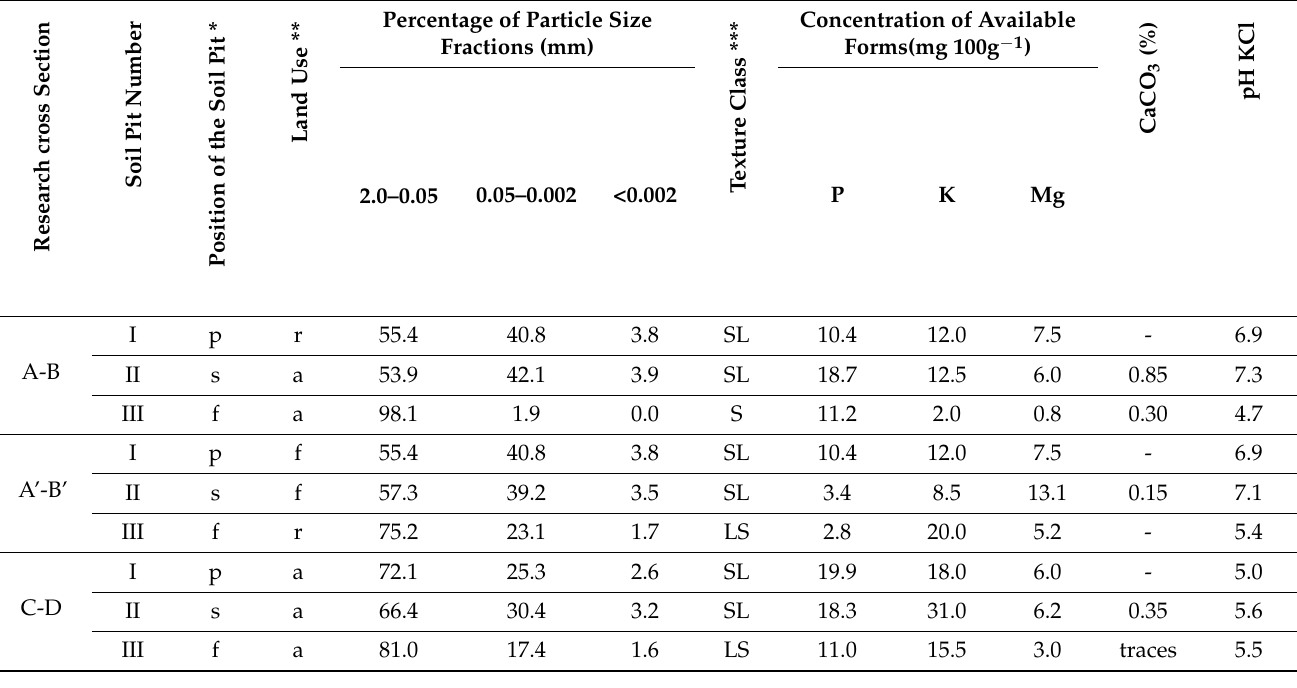
Table A1. Particle size distribution and selected chemical and physico-chemical properties of soils along the analyzed cross sections, at a depth of 0–10 cm